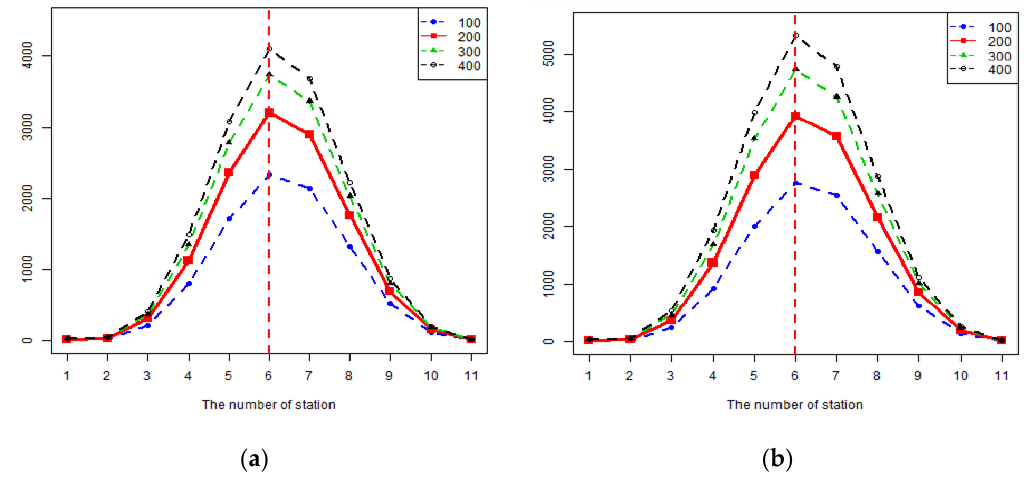
Figure 3. Maximum information of empirical probability distribution: ( a ) observation data; ( b ) prediction error.